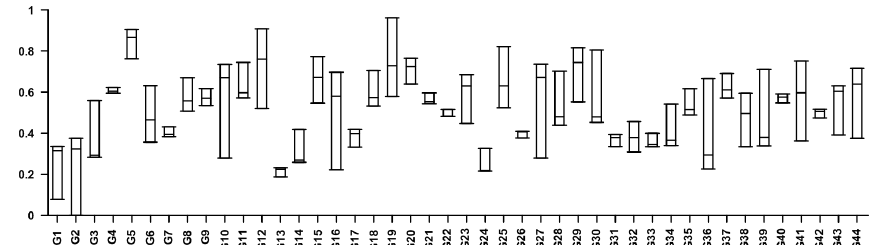
Figure 8. Determined value for R4.